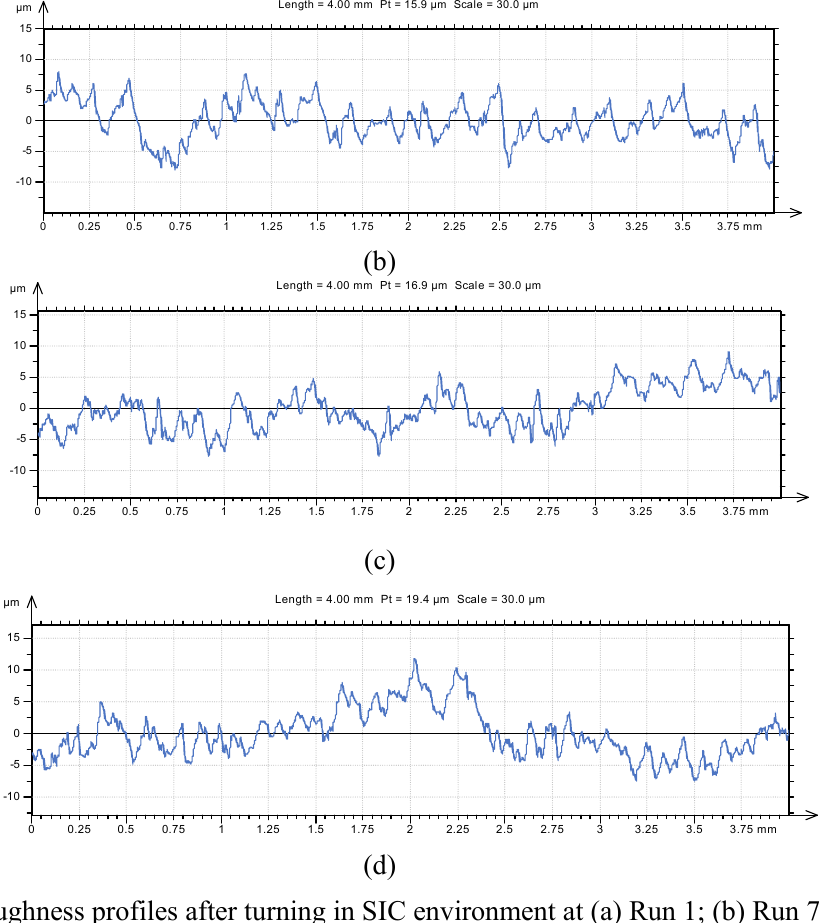
Fig. 8. Surface roughness profiles after turning in SIC environment at (a) Run 1; (b) Run 7; (c) Run 11;